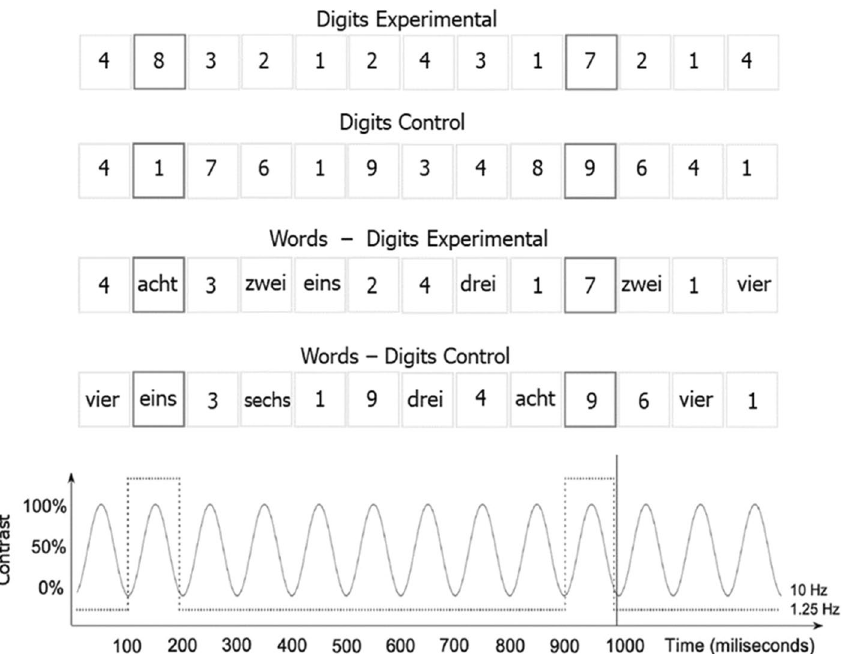
Figure 1. Visual depiction of (some of) the single and mixed notation conditions of the Frequency-tagged EEG oddball design. Sequences were presented for 48 s in both experimental and control conditions. For the experimental conditions, participants saw either single notations sequences (digits, words, or dots), or mixed notation sequences conditions (digits—words, words—dots, digits—dots). Irrespectively of the notation, numbers smaller than five were presented as base stimuli at the frequency of 10 Hz, and every 8th item, a number larger than 5 was inserted at the oddball frequency of 1.25 Hz. In the corresponding control conditions, the categories (base vs. oddball stimuli) were assigned randomly. The bottom panel illustrates the onset and the offset of each stimulus following the sinusoidal contrast modulation from a 0 to 100% contrast. The number words were presented in German, which translated into English as follows: “eins”—“one”, “zwei”—“two”, “drei”—“three”, “vier”—“four”, “fünf”—“five” (not included in the stimulus list), “sechs”—“six”,